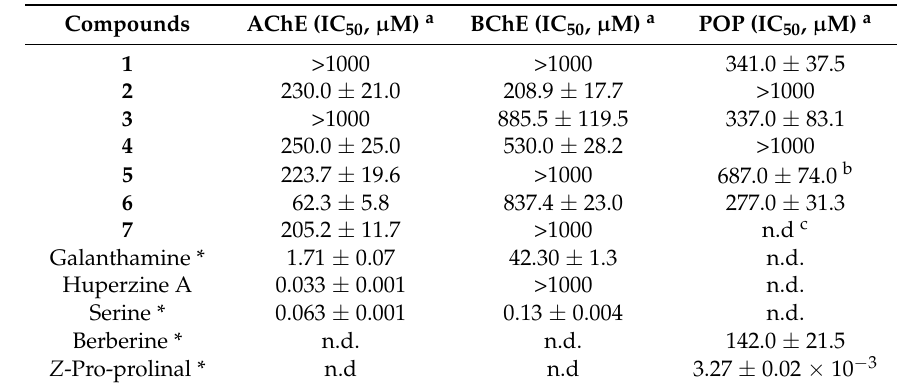
Table 2. A. platyceras alkaloids and their acetylcholinesterase (AChE), butyrylcholinesterase (BChE), and prolyl oligopeptidase (POP) inhibitory activity.